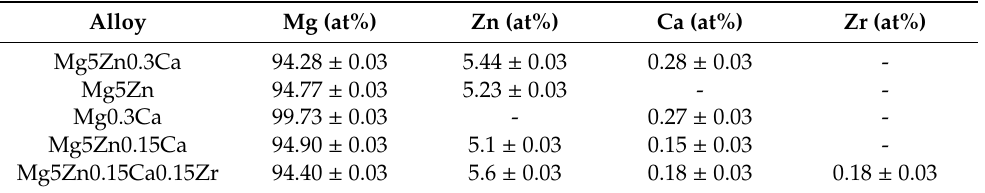
Table 1. Chemical compositions of the investigated